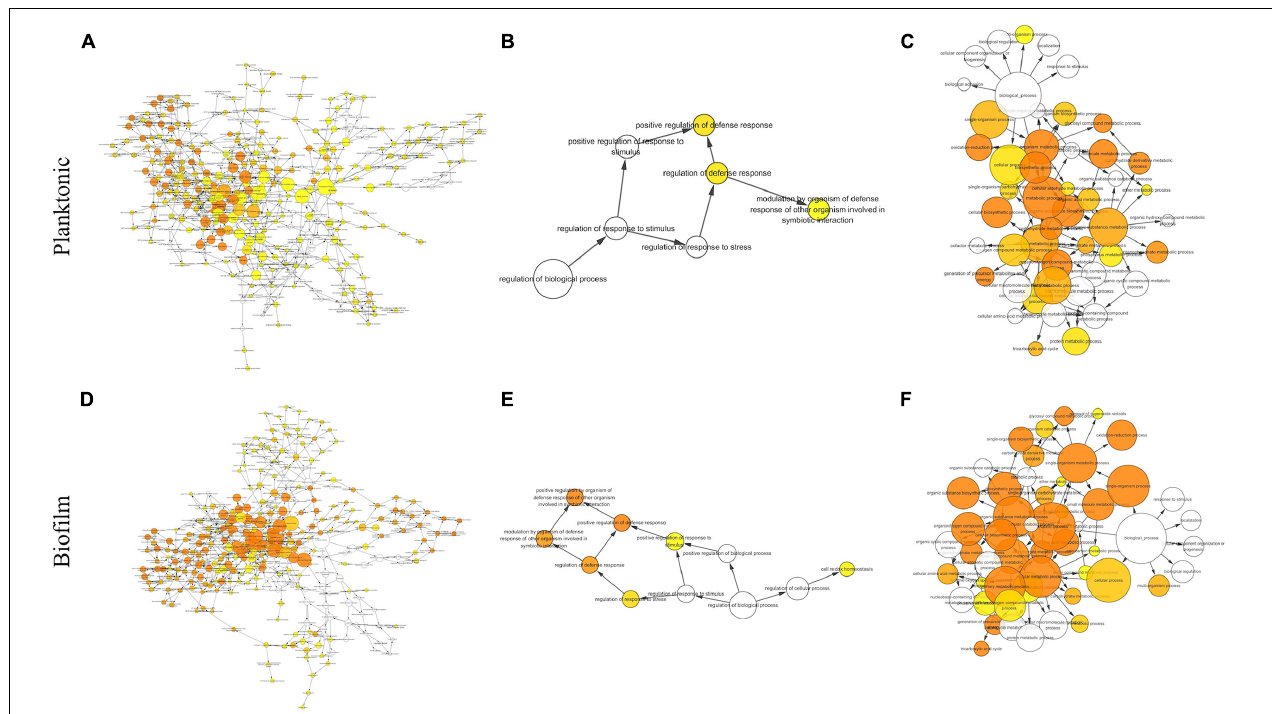
FIGURE 6 | Biological processes identified by gene ontology enrichment analysis in the planktonic cells (A–C) and biofilms (D–F) of C. albicans . Relationship networks for all the identified biological processes (A,D) , and those associated with stress response (B,E) and cellular metabolism (C,F) . Yellow nodes represent significantly enriched GO biological processes. For more significant p values, the node color is increasingly more orange. Uncolored nodes are not